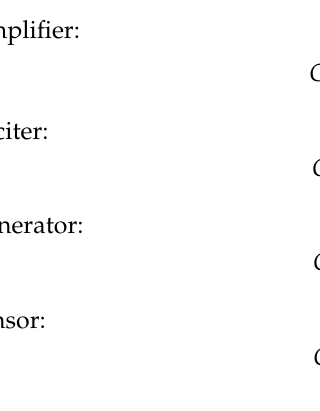
Figure 2. AVR with coupling coefficients.